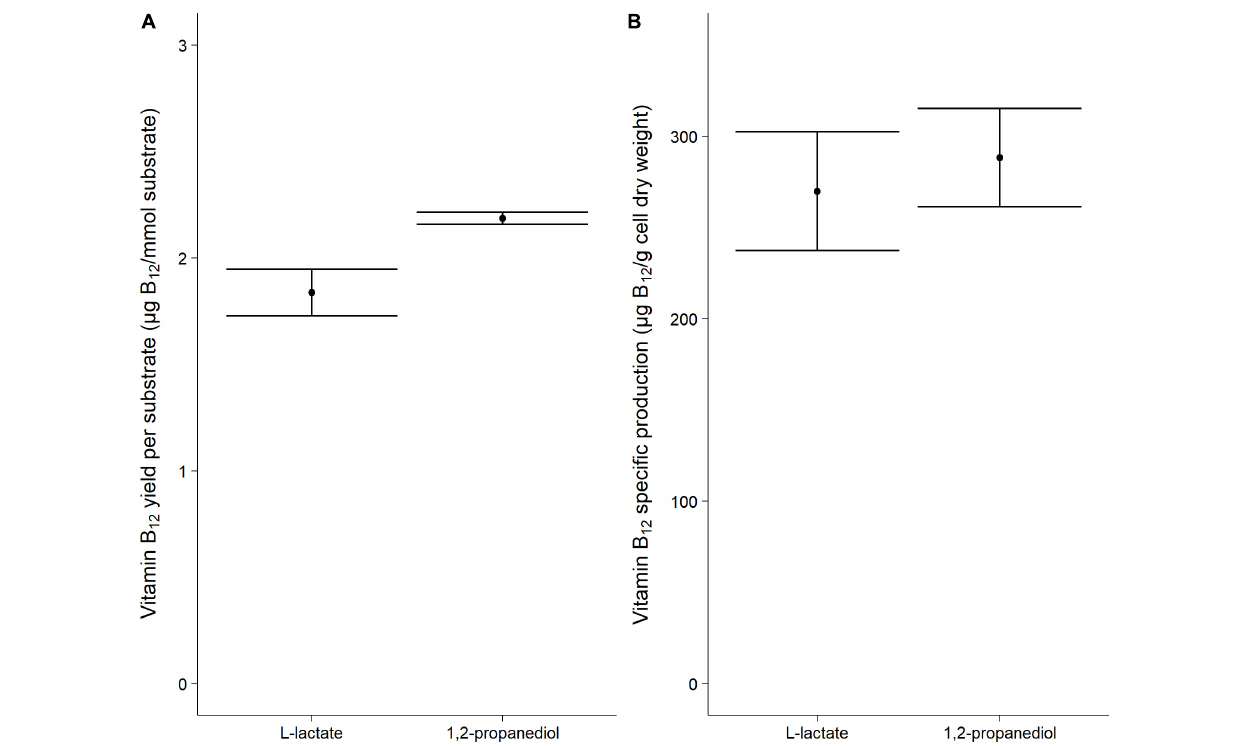
Frontiers in Microbiology |